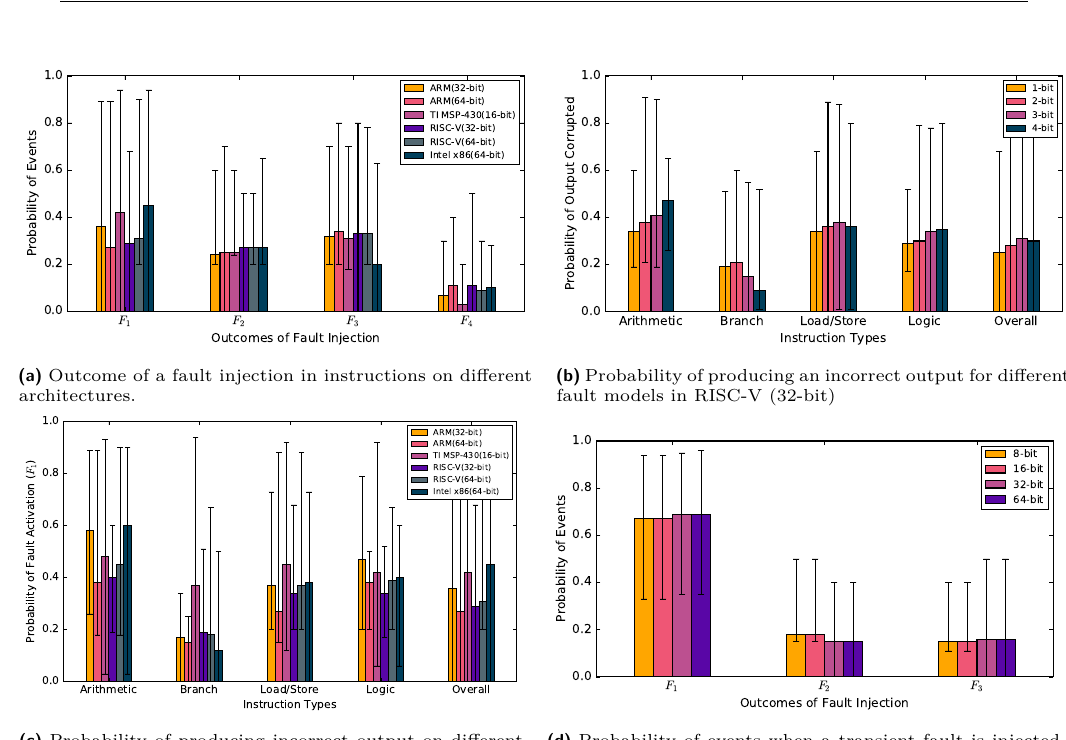
Figure 5: Probability on different microprocessors of instructions producing incorrect outputs when a transient fault is injected during